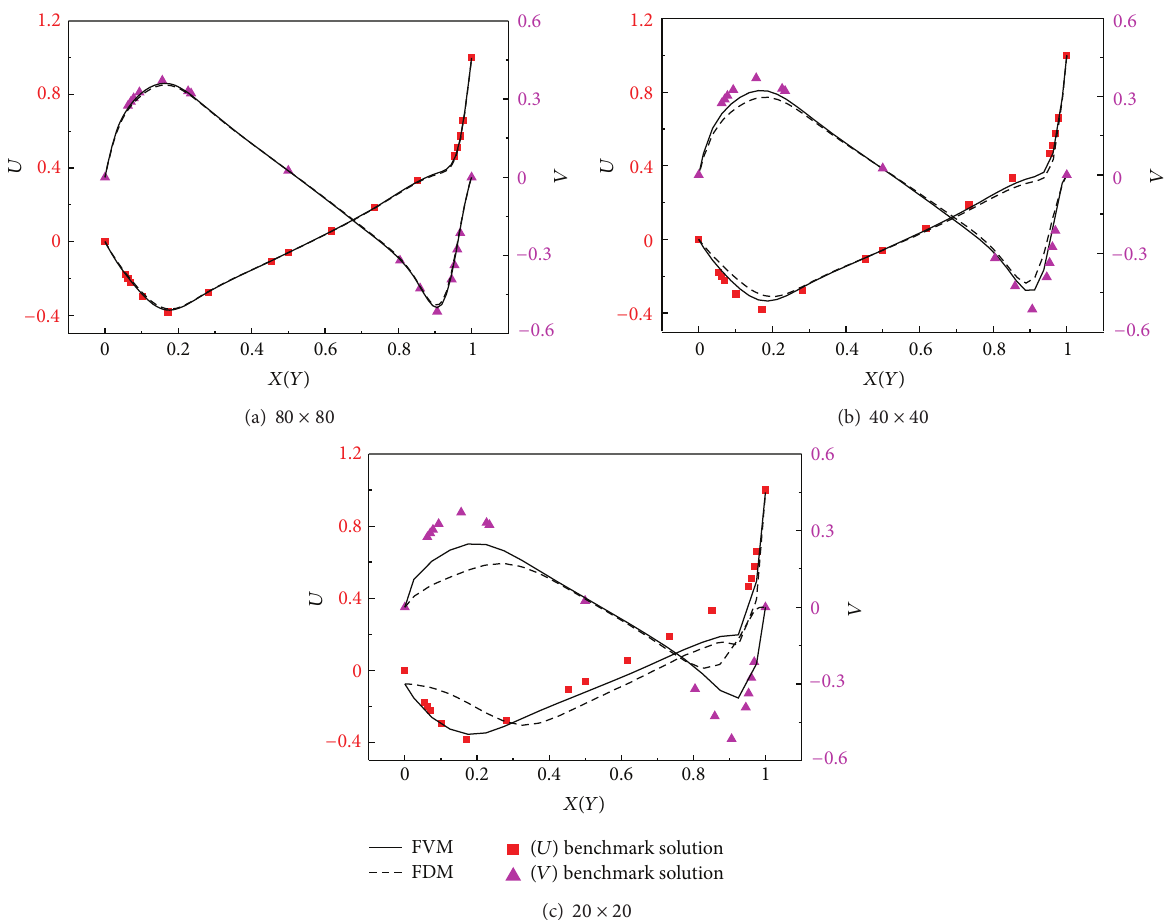
Figure 3: Velocity on the central axis of lid-driven flow obtained by MAC with variant mesh densities.